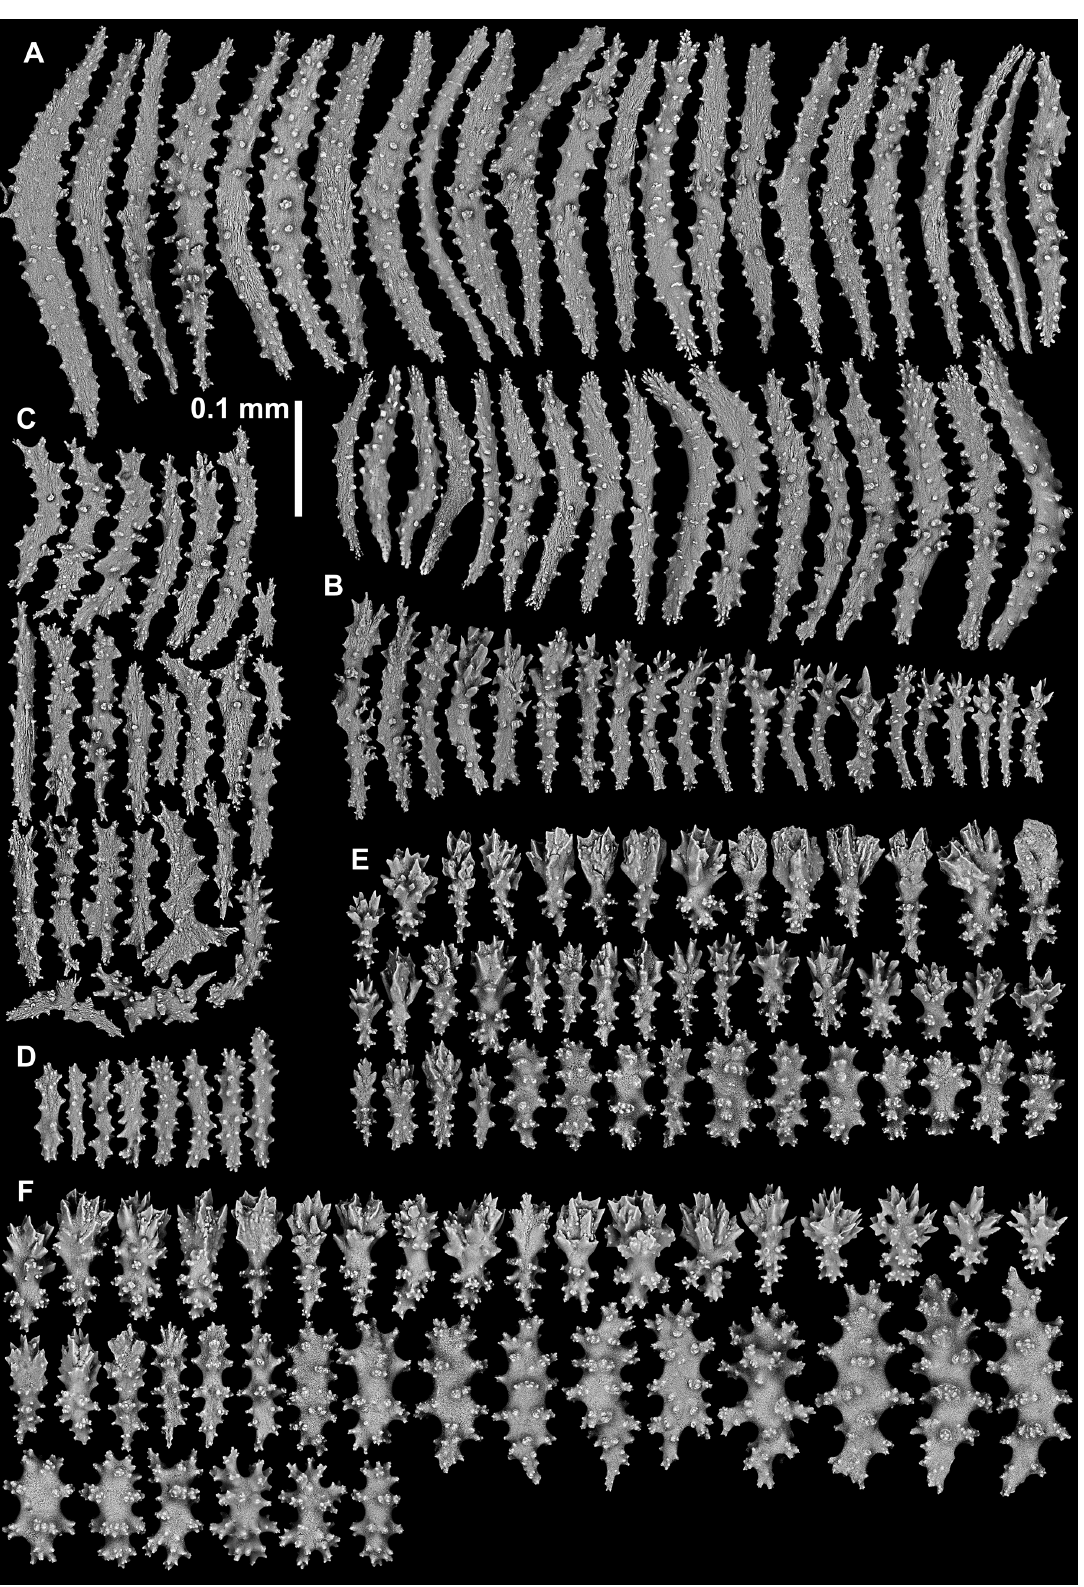
Fig. 19. Kotatea lobata gen. et sp. nov., holotype (NIWA 101313), SEMs of sclerites. A . Collaret and points. B . Distal points. C . Tentacles. D . Polyp neck. E . Polyp mound. F . Lobe